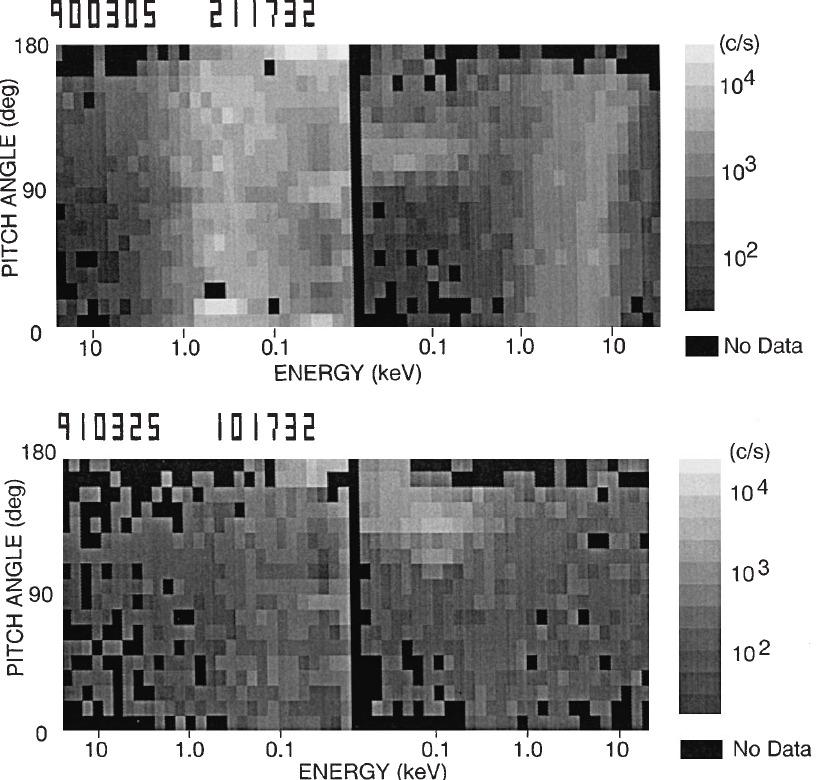
Fig. 1. An example of the simultaneous observation of the energy-pitch angle distri- bution of field-aligned electron beams and ion conics. The left side shows electrons and the right side ions. The intensity represents the count rate on a logarithmic scale as indicated on the right side. Each panel is made from integration of 16-s observation. The low-energy electrons are narrowly colli- mated along the field line. The upper panel shows the counterstreaming electrons and the lower the